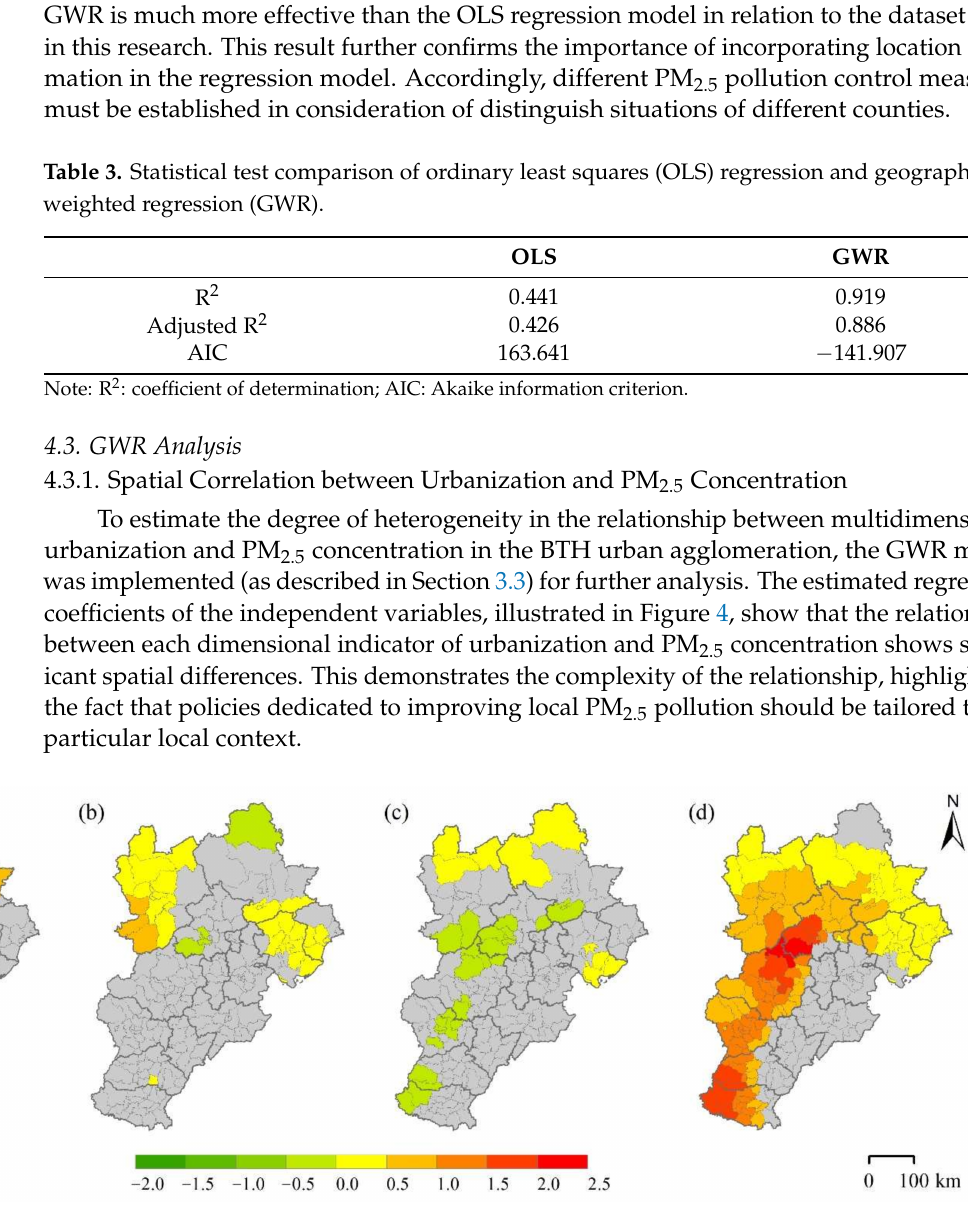
Figure 4. Spatial distribution of the local regression coefficients of the independent variable: ( a ) ln GDP, ( b ) ln POP, ( c ) ln LPI, and ( d ) ln